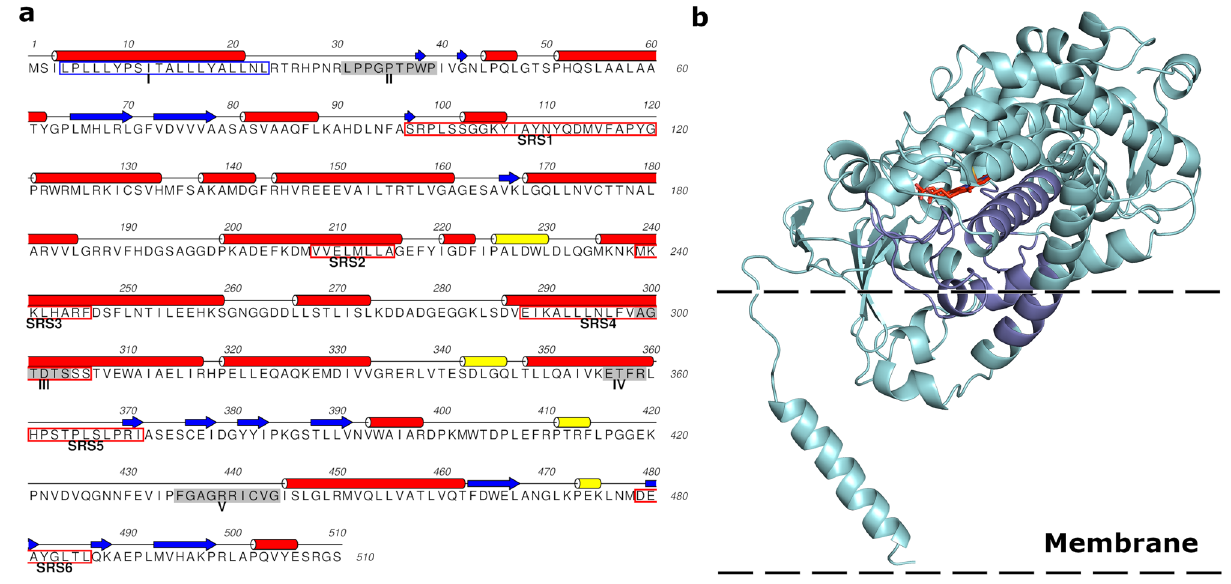
Figure 3. Structural features of Dv CH3H. ( a ) Sequence of Dv CH3H. Secondary structure features were assigned using DSSP (Dictionary of Secondary Structures of Proteins) 35 using the homology model of Dv CH3H. Grey-shaded boxes highlight II, proline-rich hinge 13,36 ; III, oxygen-binding motif; IV, EXXR triad 13,37 ; V, the P450-pattern 13,38 . The blue framed box highlights the hydrophobic membrane anchor 13 and the red framed boxes highlight the substrate recognition sites 1–6 (SRS1-6) 32–34 . (b) Homology model of Dv CH3H. The SRS regions is colored dark blue and the heme is coloured red. The putative orientation in and on the membrane of the endoplasmic reticulum has been roughly estimated according to the discussion in the literature 39 .